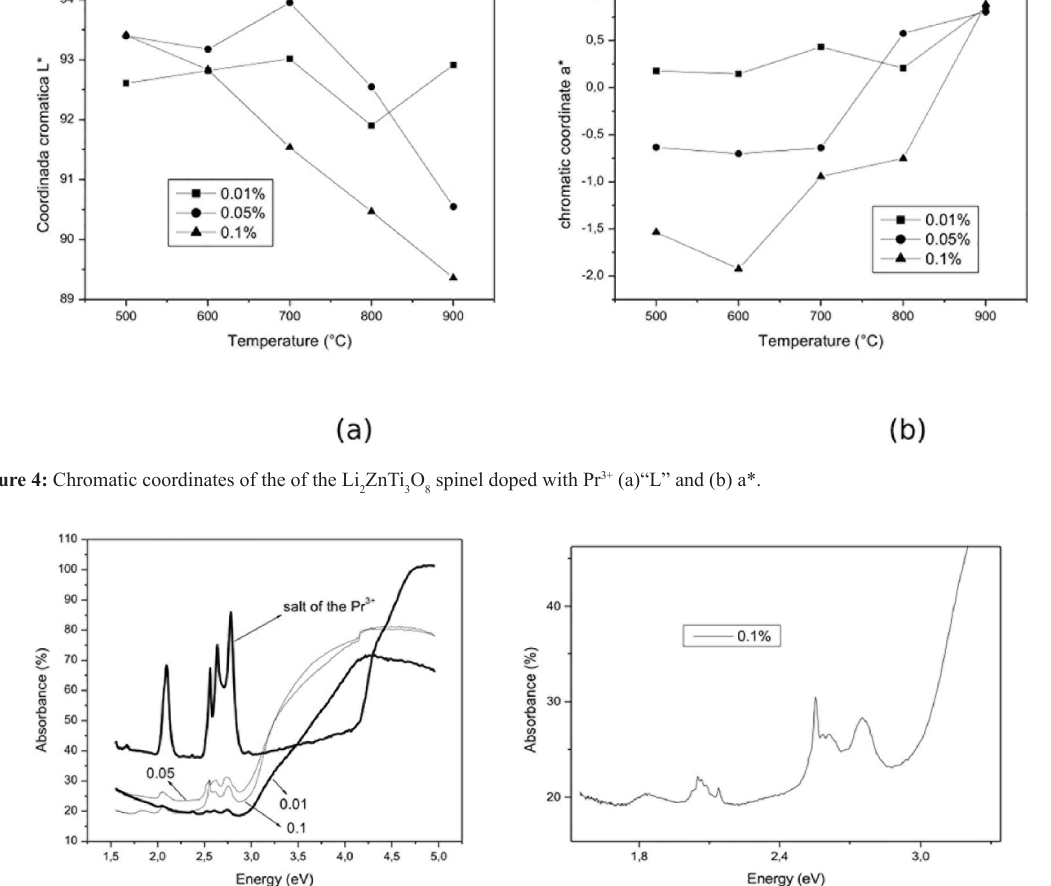
ZnTi O spinel doped with Pr 3+ (a) 0.01, 0.05 and 0.1 mol% (b) amplification of the 0.1% curve, 2 3 8 manifolds of Pr 3+ ion in Li j